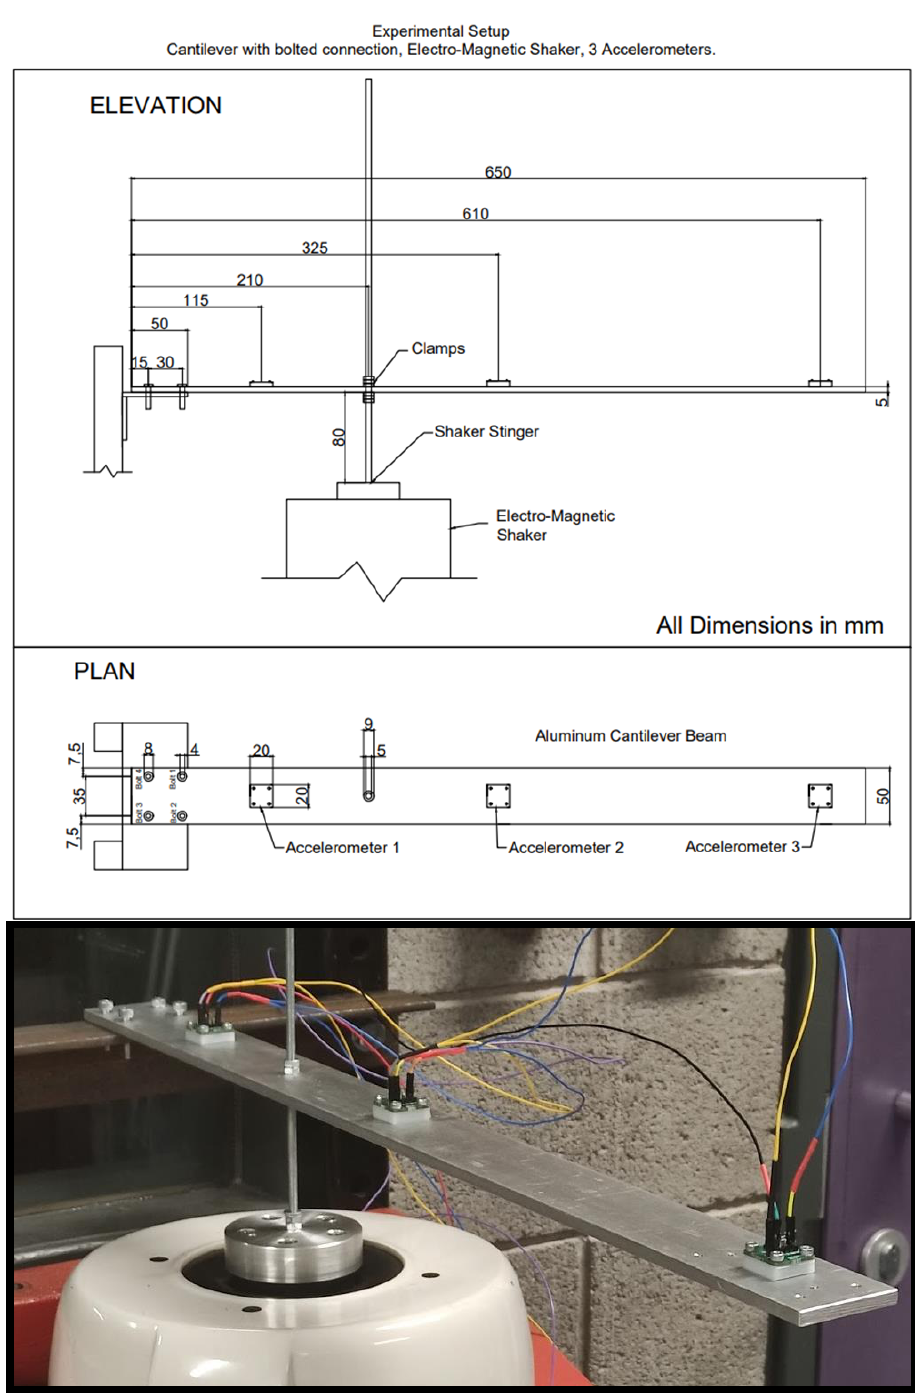
Figure 4. Experiment setup with shaker, cantilever and sensors connected to Arduino Due. The natural frequency of the cantilever is analytically calculated as 11.06 Hz. With the attached stinger and the change in boundary conditions, the natural frequency is com- puted to be 20.398 Hz. These values correspond to numerical and experimental work on two-span beams in [24,25]. Increasing and decreasing swept sine, along with white noise excitation, are used to excite the beam for each bolt-loosening incident at the fixed end of the cantilever (Figure 5), in a frequency range of 5–200 Hz and for 5 s. Tables A1 and A2 in Appendix A show the progression of bolt loosening for the two sets of damage experi- ments.